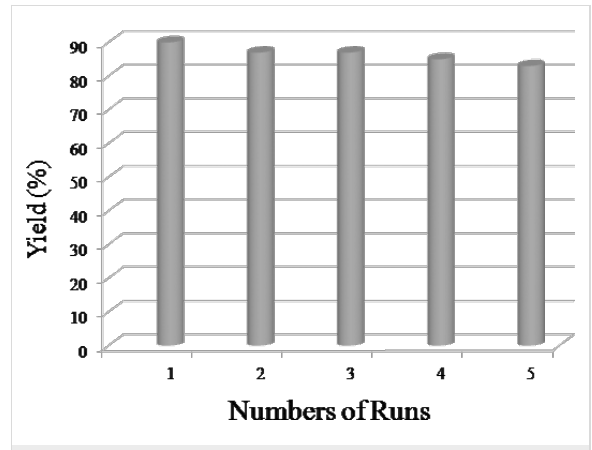
Figure 2: Reusability of SSA for the synthesis of pyrrole-fused